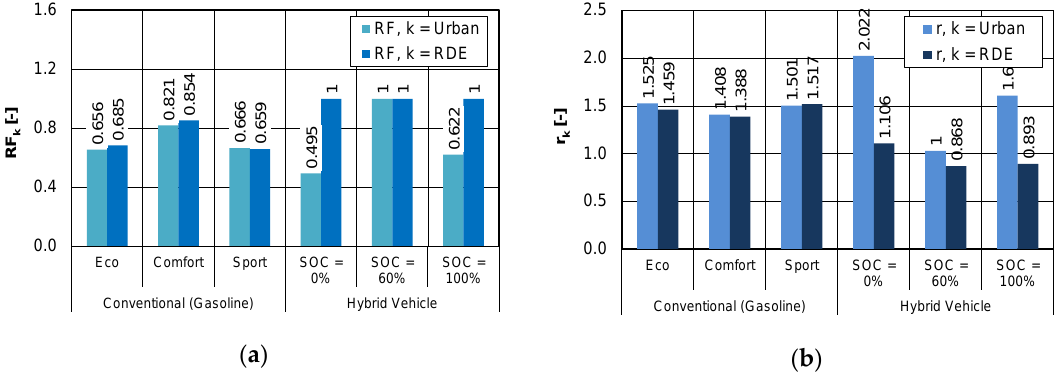
Figure 10. Value of the RF k ( a ) and r k ( b ) of the carbon dioxide emission increase for all test drives.